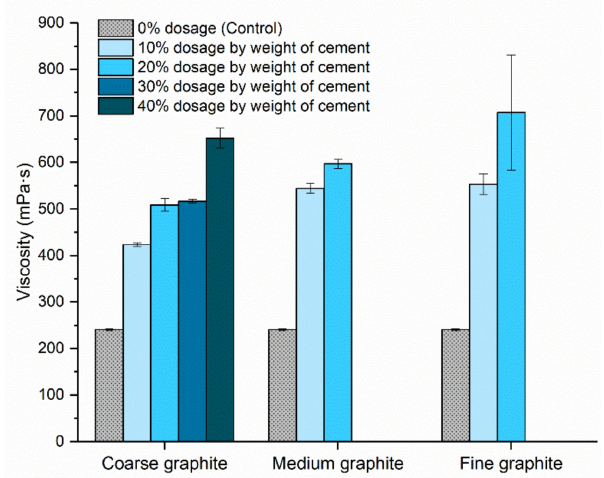
Figure 6. E ff ect of natural graphite size and concentration on the viscosity (mPa · s) of cement